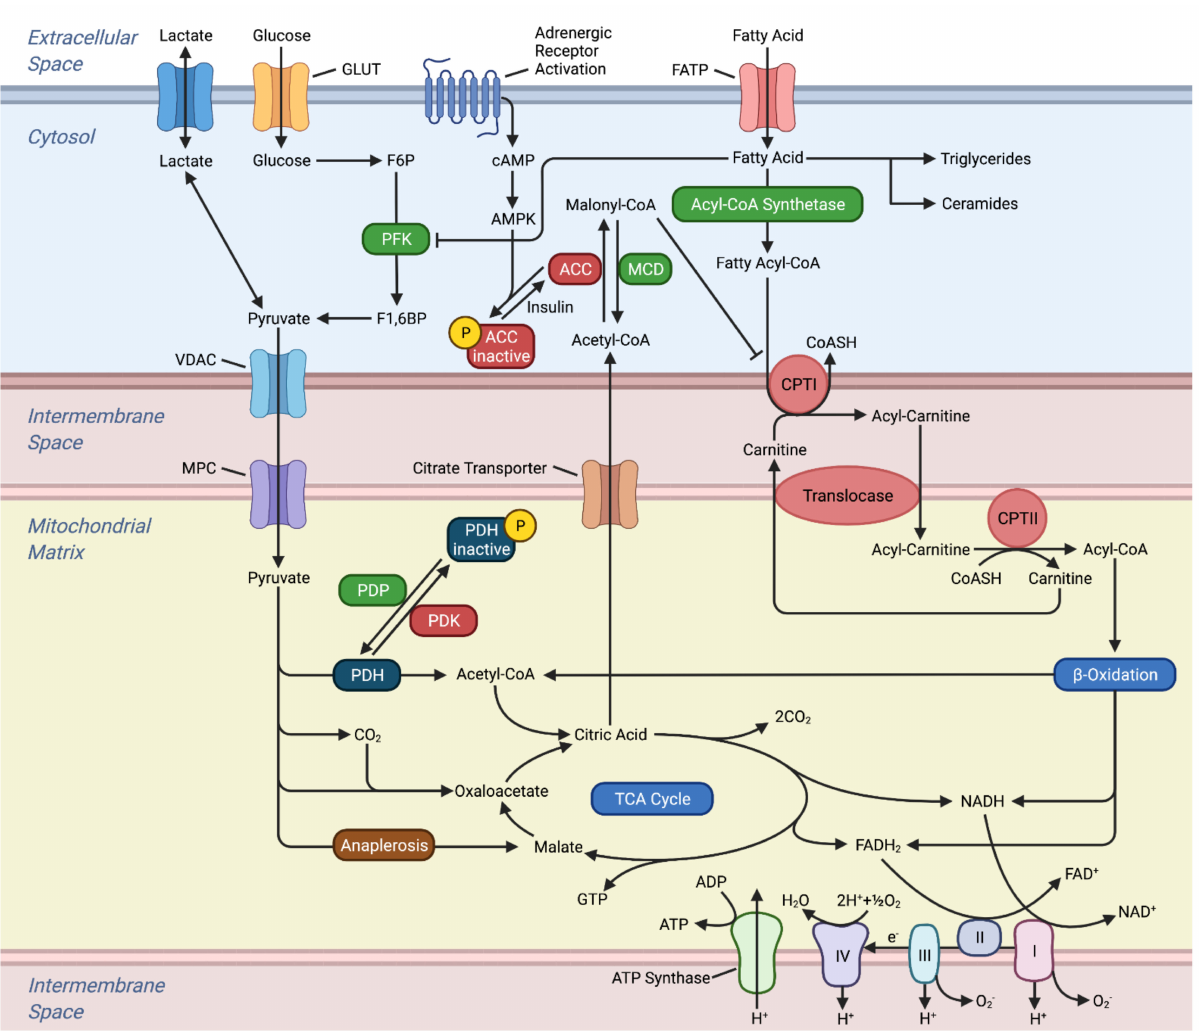
Figure 1. Metabolism in the Healthy Heart. This figure illustrates the oxidation and transport of glucose and fatty acids in the heart. The electron carriers generated from β -oxidation and the TCA cycle, which subsequently enters the electron transport chain. Abbreviations, ACC: acetyl-CoA car- boxylase, ADP: adenosine diphosphate, AMPK: adenosine monophosphate activated protein